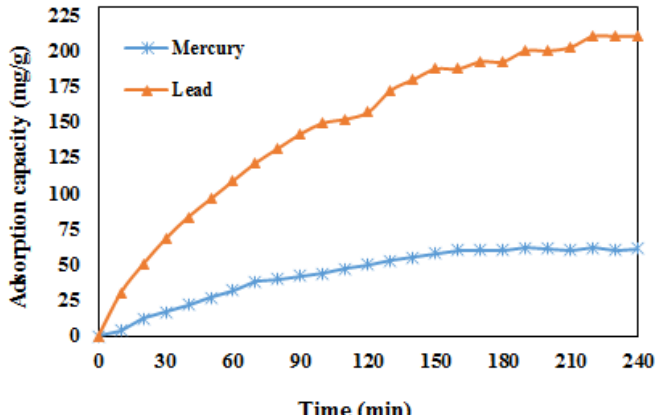
Fig. 5. Effect of contact time on adsorption capacity (pH=8, T=298 K, initial concentration for Pb(II) =100 mg/L and for Hg(II)= 20 mg/L).